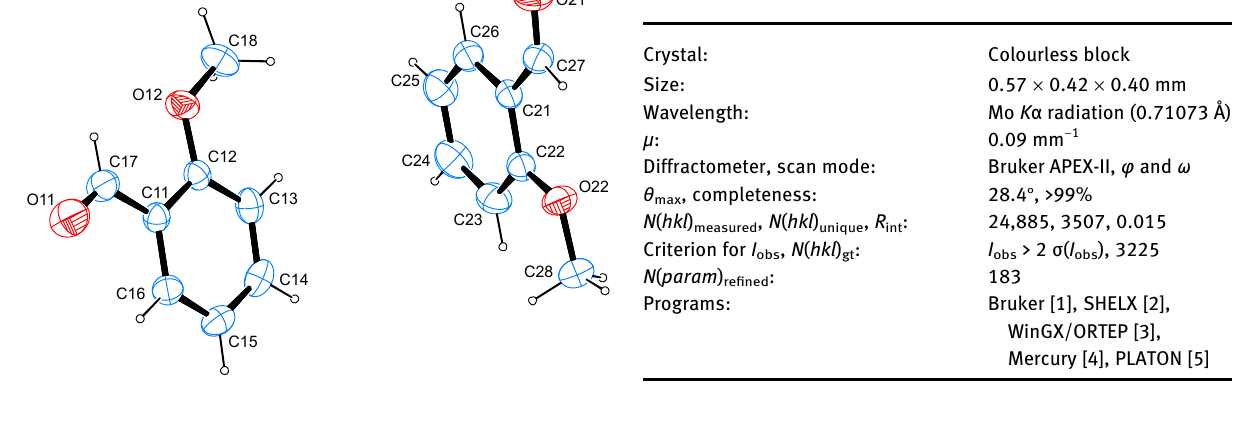
Table  : Data collection and